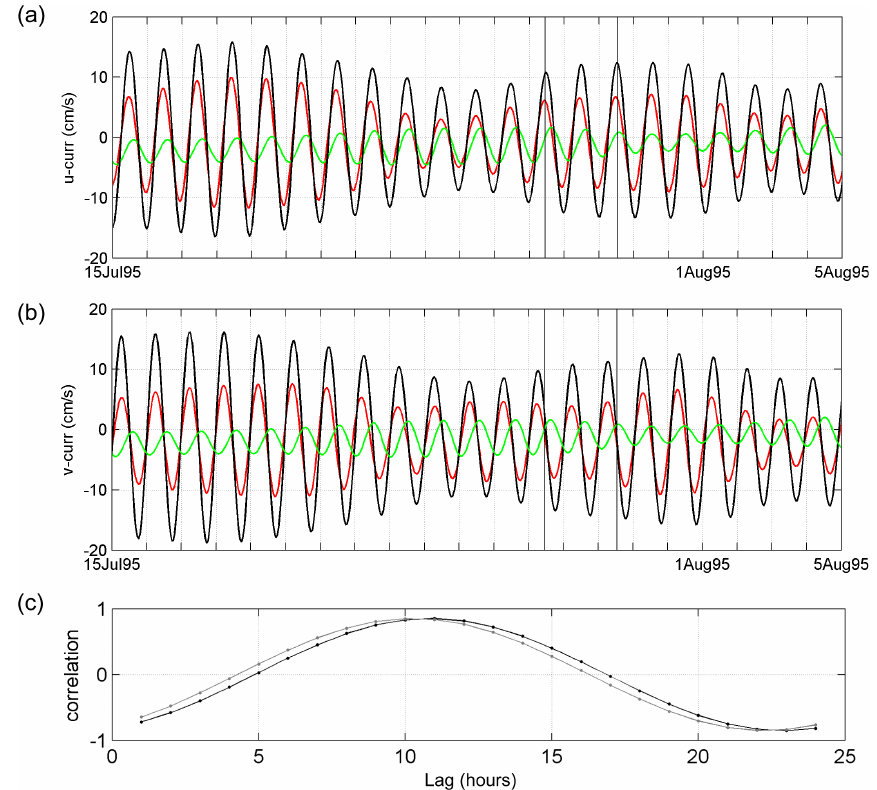
Fig. 15. 24h-centered bandpass filtered data for u (a) and v (b) current components at the upper current-meter (red line) and bottom current- meter (black line); the 24h-centered bandpass filtered sea level (in cm) is indicated in green. (c) lagged cross-correlation between the wavelet-extracted diurnal scales of the sea level and the u current component as a funtion of the lag interval; the upper layer is black and the bottom is grey.